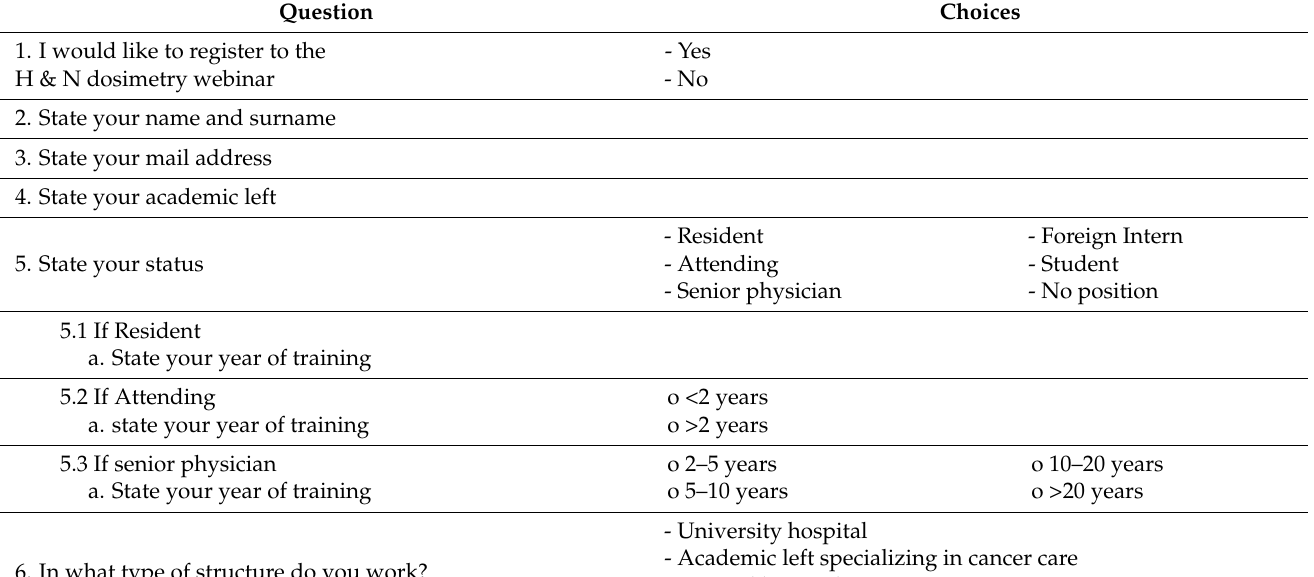
Table 1. Submitted Form translated into